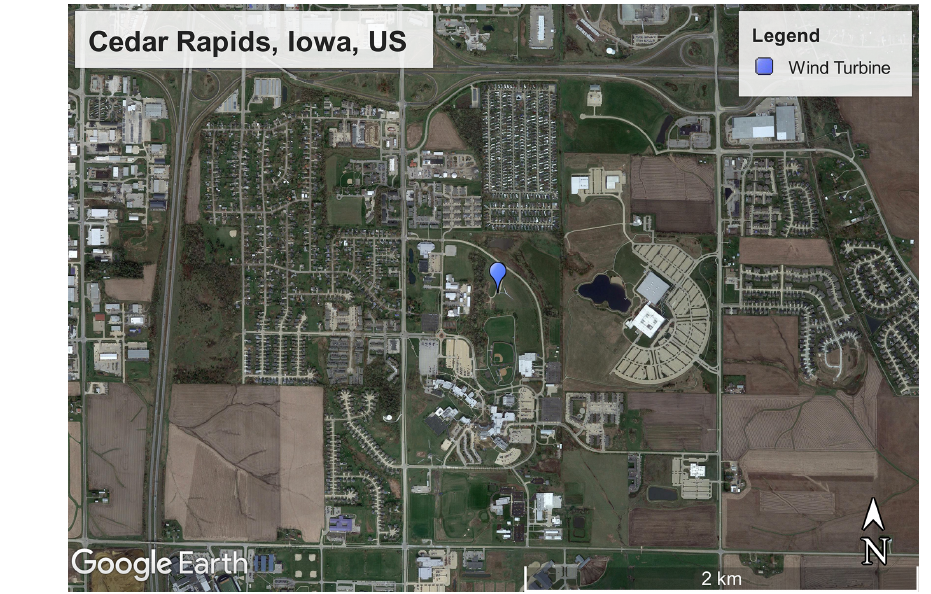
Figure 1. Satellite image of the measurement site with the location of the wind turbine (© Google Earth). The wind turbine coordinates are 41 . 9165 ◦ latitude and − 91 . 6508 ◦